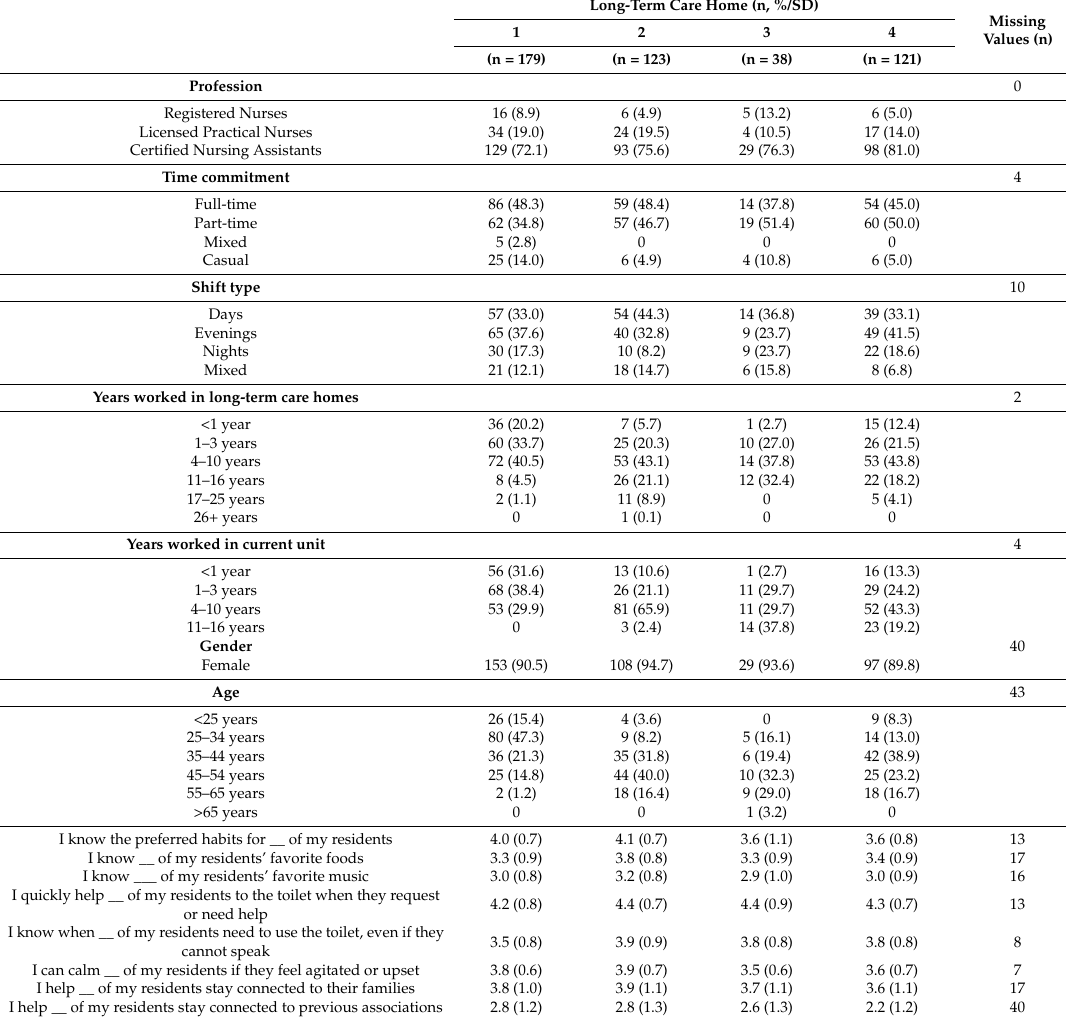
Table 3. Description of TM-PCC Survey